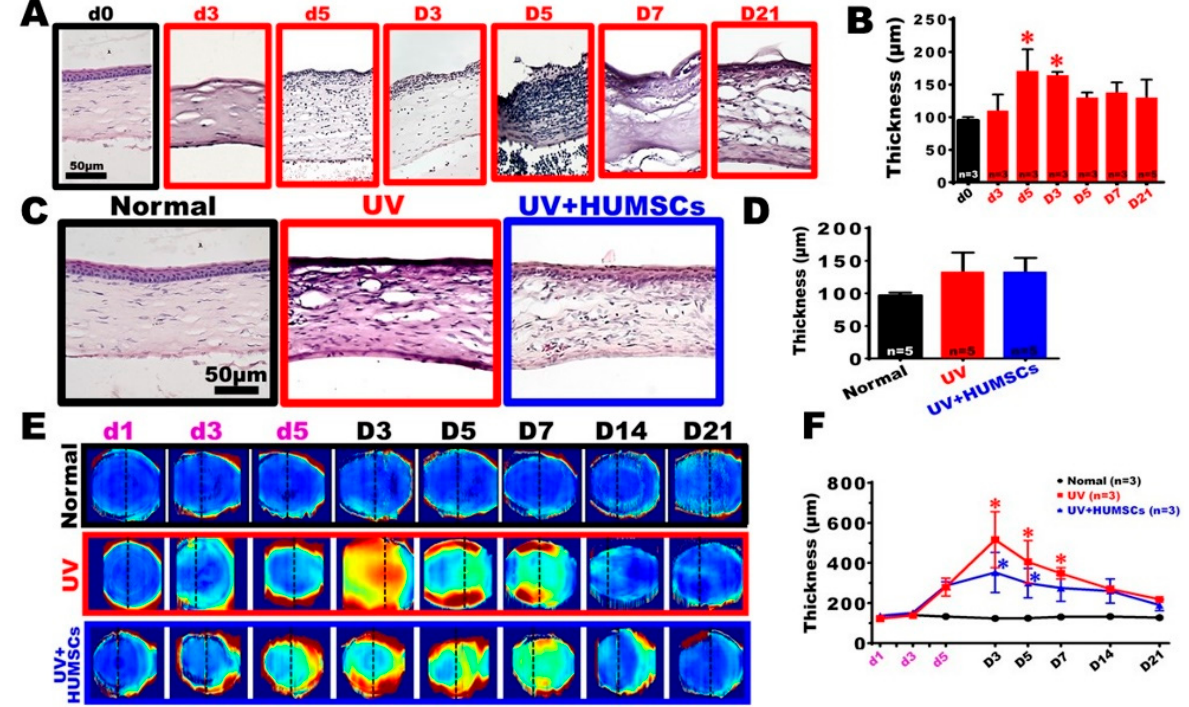
Figure 2. HUMSC transplantation alleviates corneal edema following UV irradiation. Hematoxylin staining and thickness analyses of the histological sections ( A , B ). Non-keratinized stratified squamous epithelium and mostly developed stroma were observed in the Normal group. Histological analysis of the irradiated cornea, swelling, and accumulation of infiltration cells in the stroma layer contributed to the thickness. The graph shows that the thickness significantly increased on day 5 and day 3 after UV irradiation ( B ). On day 21, after UV irradiation, pseudo-keratinization was observed in rats of the UV groups. In contrast, a significant enhancement of the intact epithelium was observed in the rats of the HUMSC groups ( C ). The graph shows the thickness of the corneas on day 21 after UV irradiation ( D ). The corneal thickness map ( E ) and average thickness within a 1-mm radius around the cornea center ( F ) were performed by quantitative analysis of the 3D OCT images. * vs. the Normal group at the same time, p <